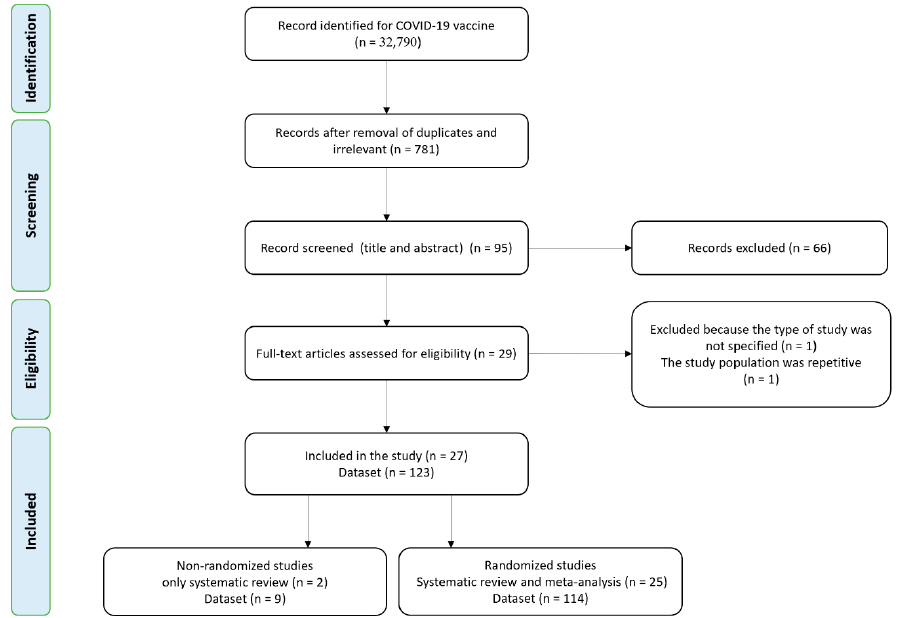
Figure 1. Flow diagram of literature search and study selection for meta-analysis (PRISMA flow chart).